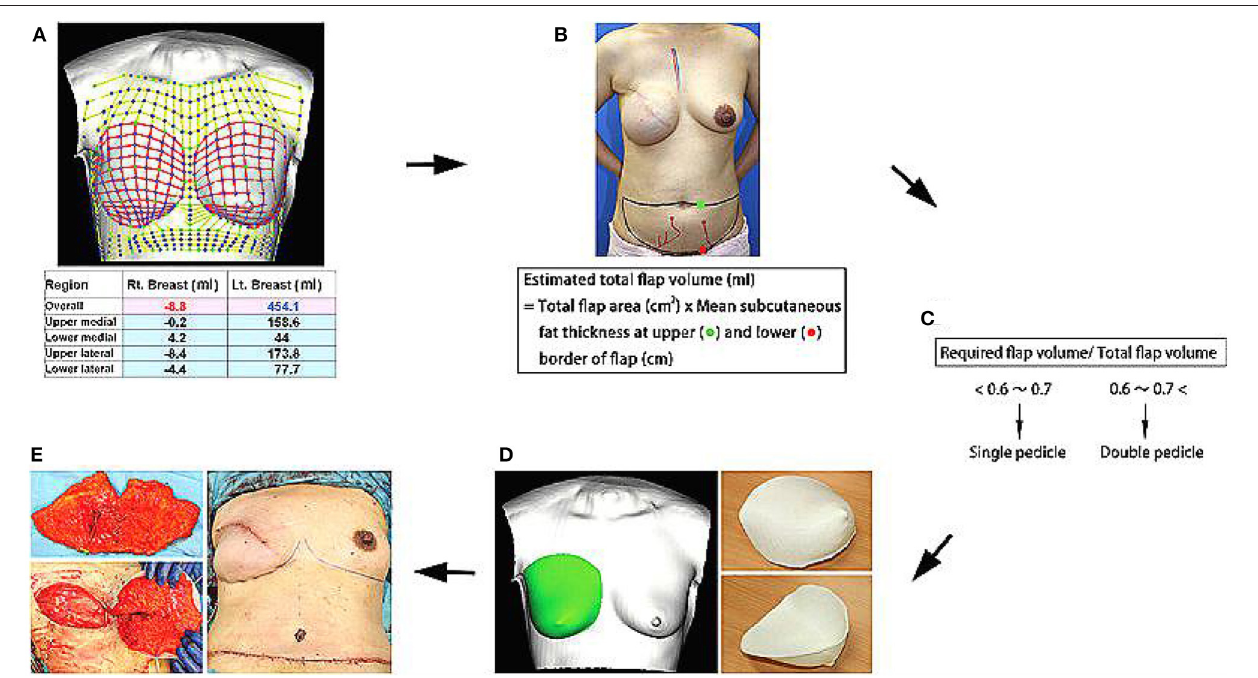
FIGURE 5 | (A) Required flap volume was estimated from bilateral breast images using a 3D image data analysis software. (B,C) Total flap volume was estimated using the formula shown, and flap type was determined preoperatively. (D) Contralateral breast shape was horizontally inverted, and an acrylonitrile–butadiene–styrene